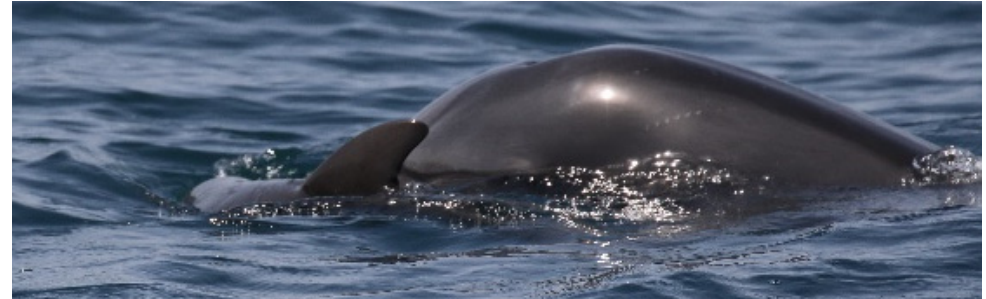
to take any pictures to confirm it.